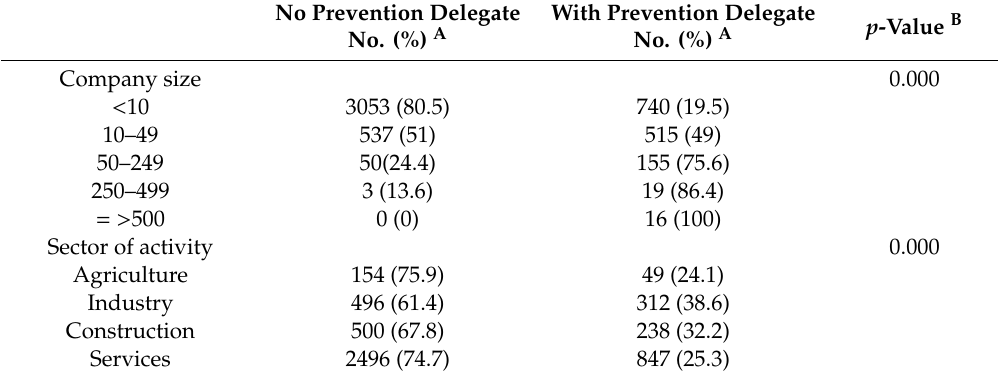
Table 1. Distribution of unitary prevention delegates according to company size and activity